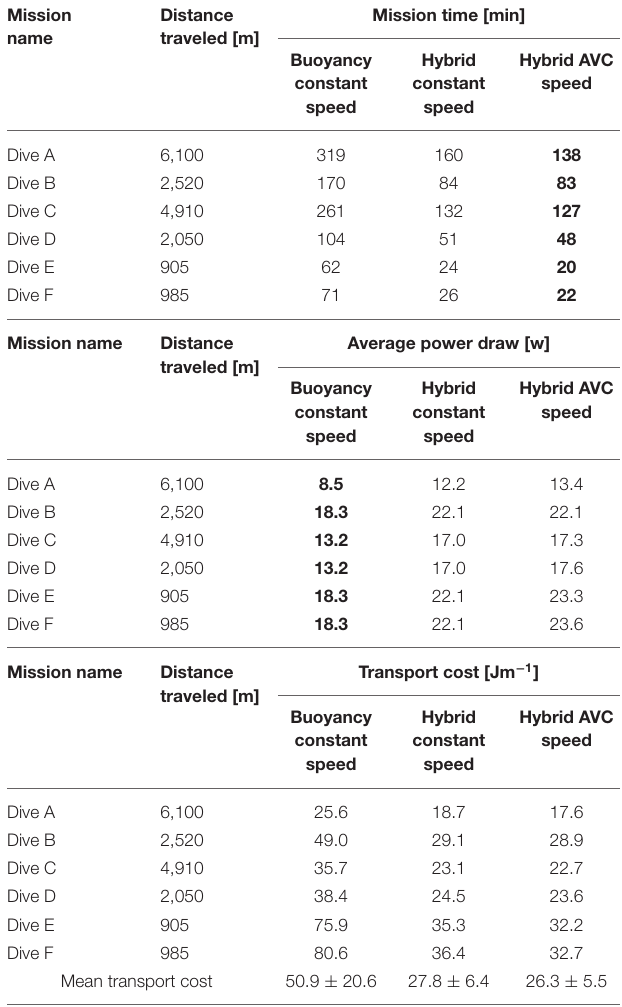
TABLE 2 | Offline performance analysis between three glider velocity control policies applied to November 2019 southern Aegean Sea missions previously mentioned: constant velocity with the buoyancy engine alone, constant velocity with the hybrid buoyancy and thruster system, and adaptive velocity control (AVC) with the hybrid buoyancy and thruster system.